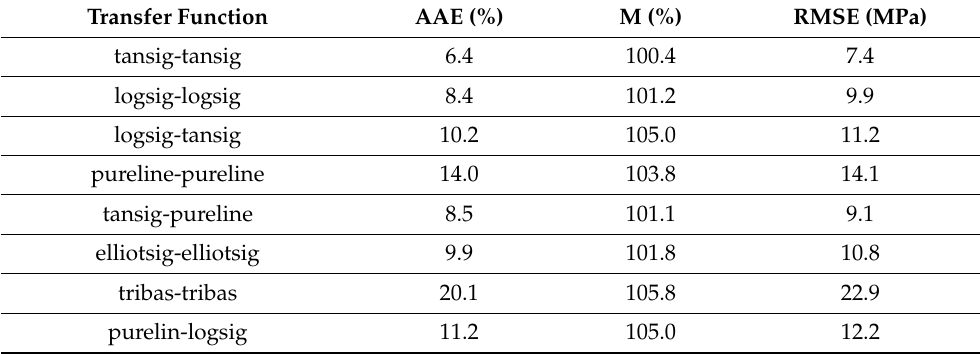
Table 5. Summary of different studied cases for transfer function in predicting f’ cc .